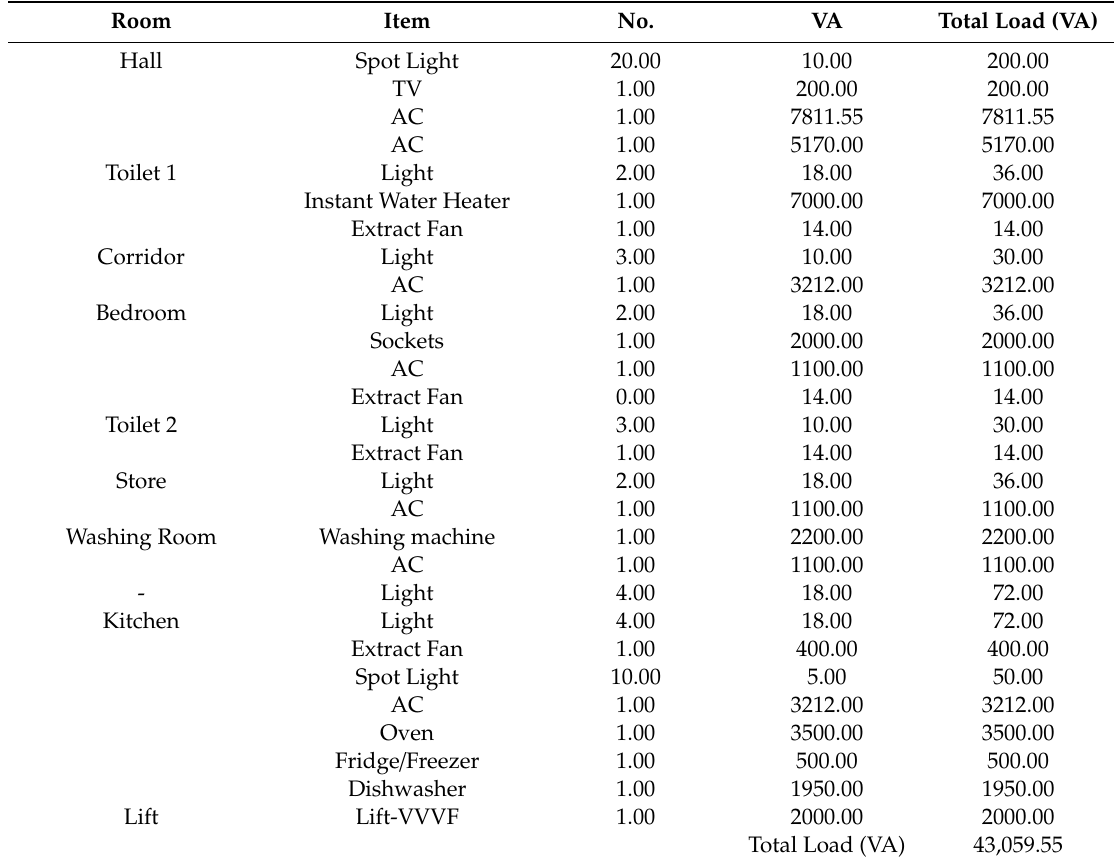
Table A3. List of the loads for the second floor in each Villa.